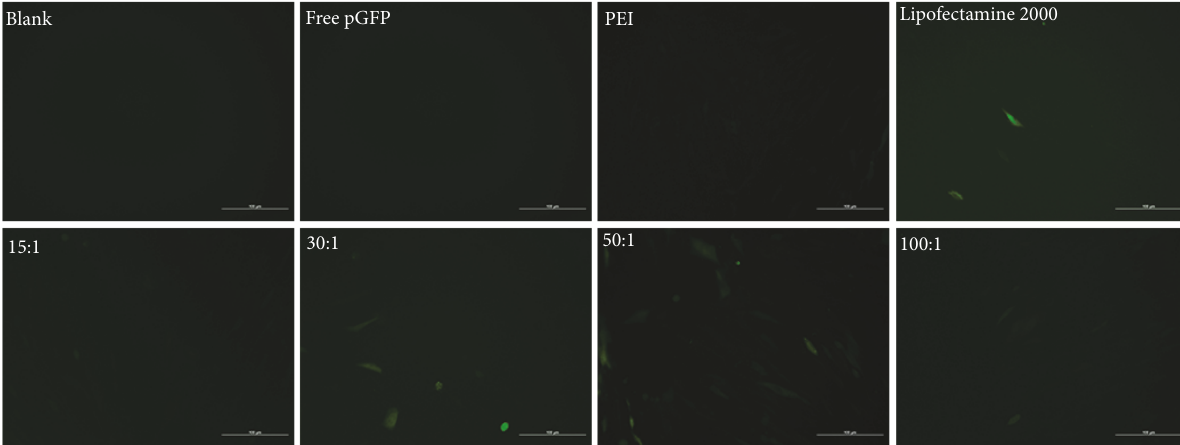
Figure 4: GFP transfection. Notes: Blank: 3T6 cells treated with only pm-PPY; free pGFP: 3T6 cells transfected with only GFP plasmid; Lipofectamine 2000: 3T6 cells transfected with Lipofectamine 2000-pGFP nanoparticles; 15:1: 3T6 cells transfected with pm-PPY-pGFP at a weight ratio of 15:1; 30:1: 3T6 cells transfected with pm-PPY-pGFP at a weight ratio of 30:1; 50:1: 3T6 cells transfected with pm-PPY-pGFP at a weight ratio of 50:1; 100:1: 3T6 cells transfected with pm-PPY-pGFP at a weight ratio of 100:1.